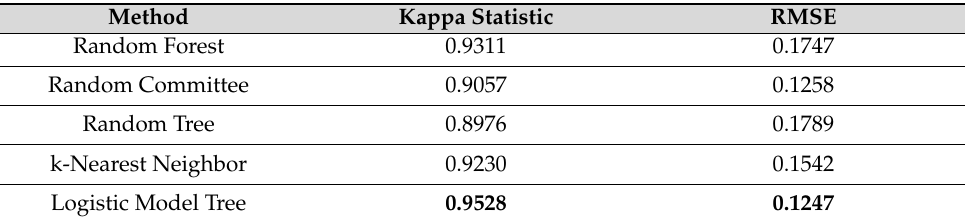
Table 11. Kappa statistics and RMSE values of algorithms on cancer stage classification with all attributes. (Illustrations by the authors).